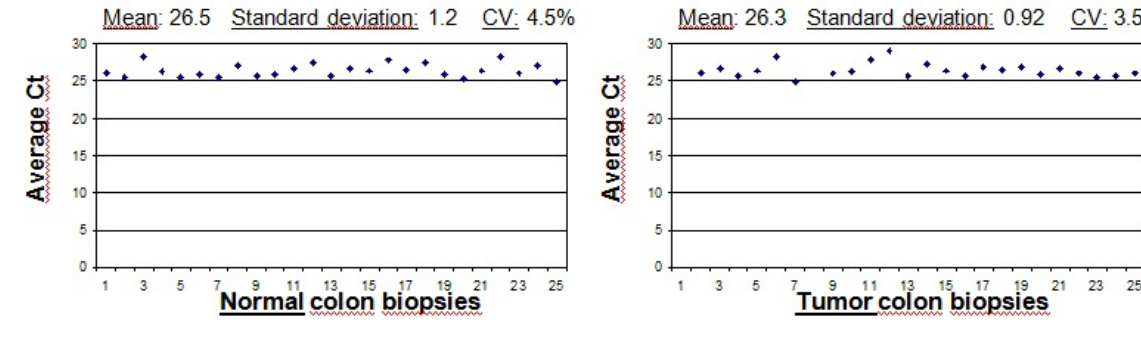
Figure 7. Comparison of RNA–ß2- microglobulin gene expression from 25 normal and tumor colon biopsies,